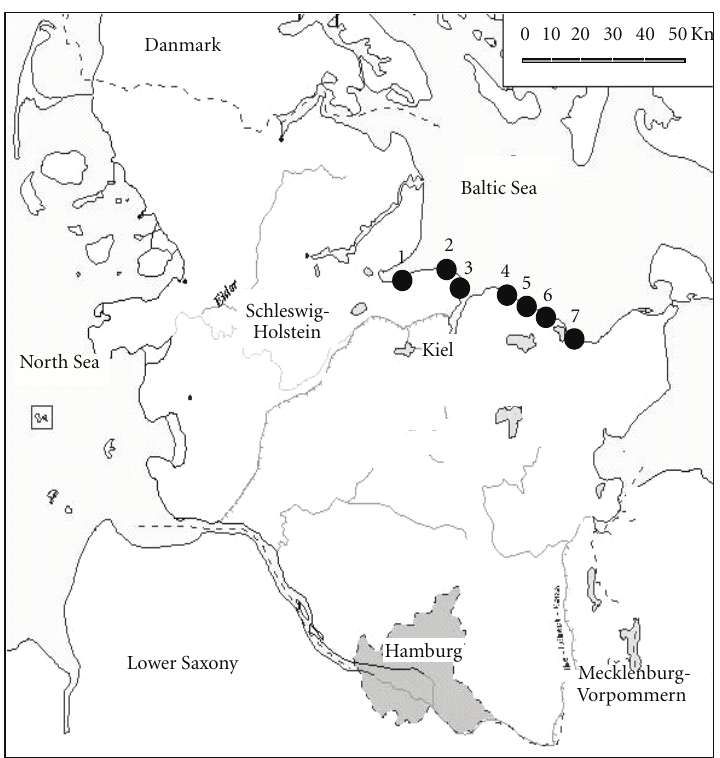
Figure 1: Investigated locations at the Baltic Sea coast: Lindh¨oft (1), D¨anisch-Nienhof (2), Stohl (3), Stakendorf and Hohenfelde (4), Hubertsberg (5), Behrensdorf and Lippe (6), and Weißenhaus (7).